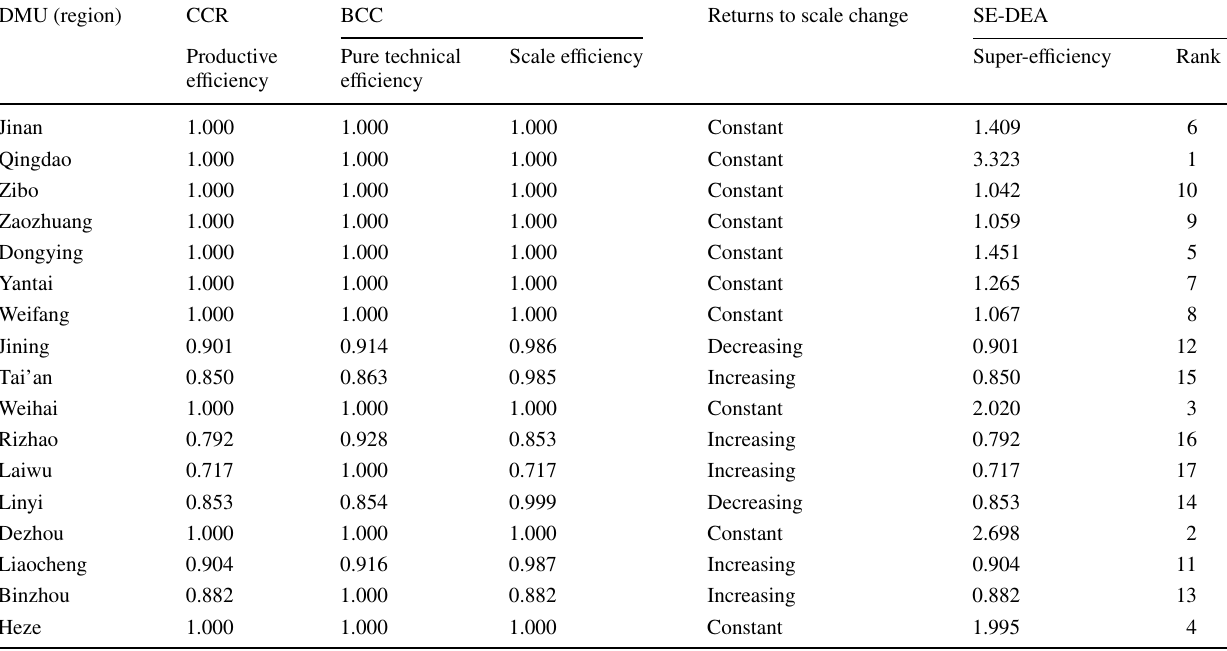
Table 1 Water use efficiency scores of 17 regions of Shandong Province in 2015 and their rank DMU (region) CCR BCC Returns to scale change